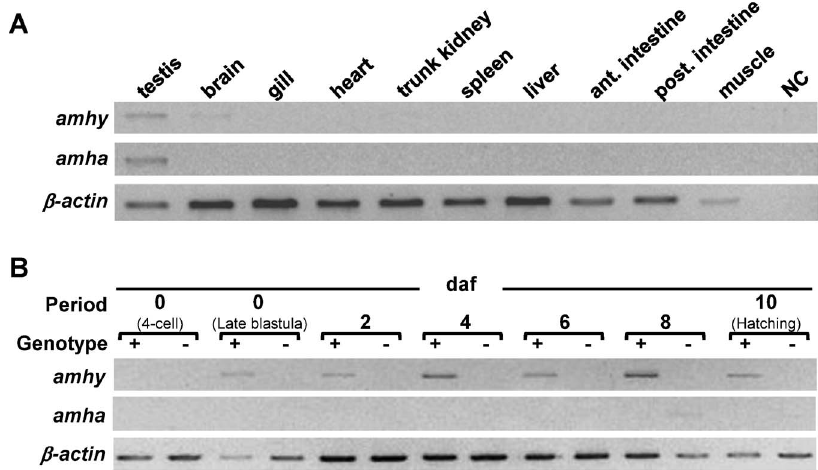
Figure 2. Expression of amhy and amha mRNAs in tissues and embryos. A : Tissue distribution of amhy and amha mRNAs in juvenile pejerrey (RT-PCR). B : Expression profile of amhy and amha during embryogenesis in amhy + / 2 and amhy 2 / 2 genotypes (RT-PCR). b -actin was used as endogenous control. NC: negative control. doi:10.1371/journal.pone.0102574.g002 PLOS ONE |